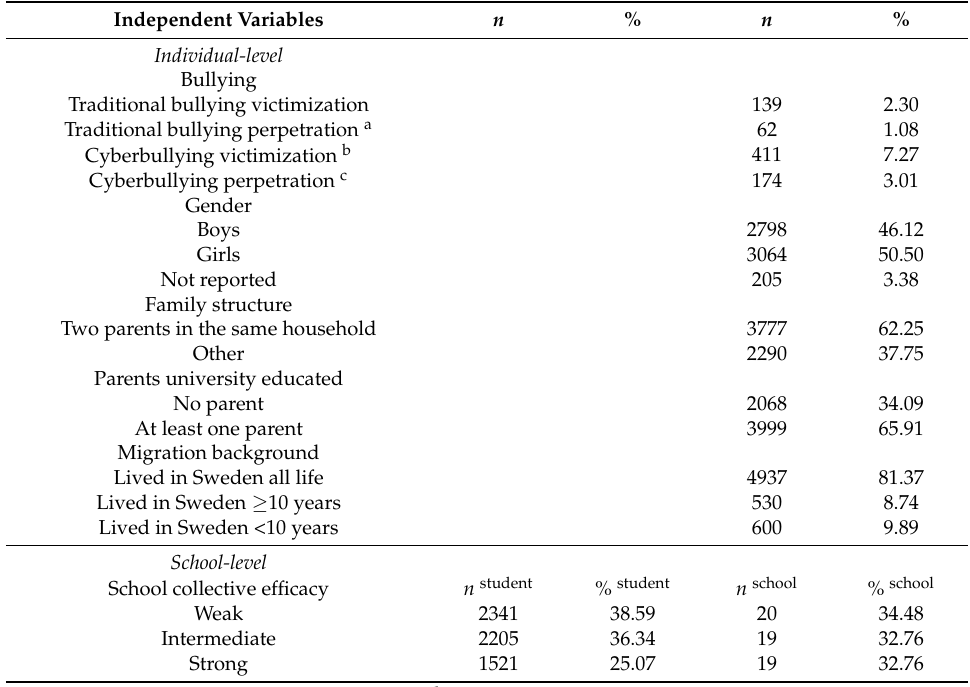
Table 1. Descriptive statistics of variables included in the analyses. n = 6067 students in 58 schools.